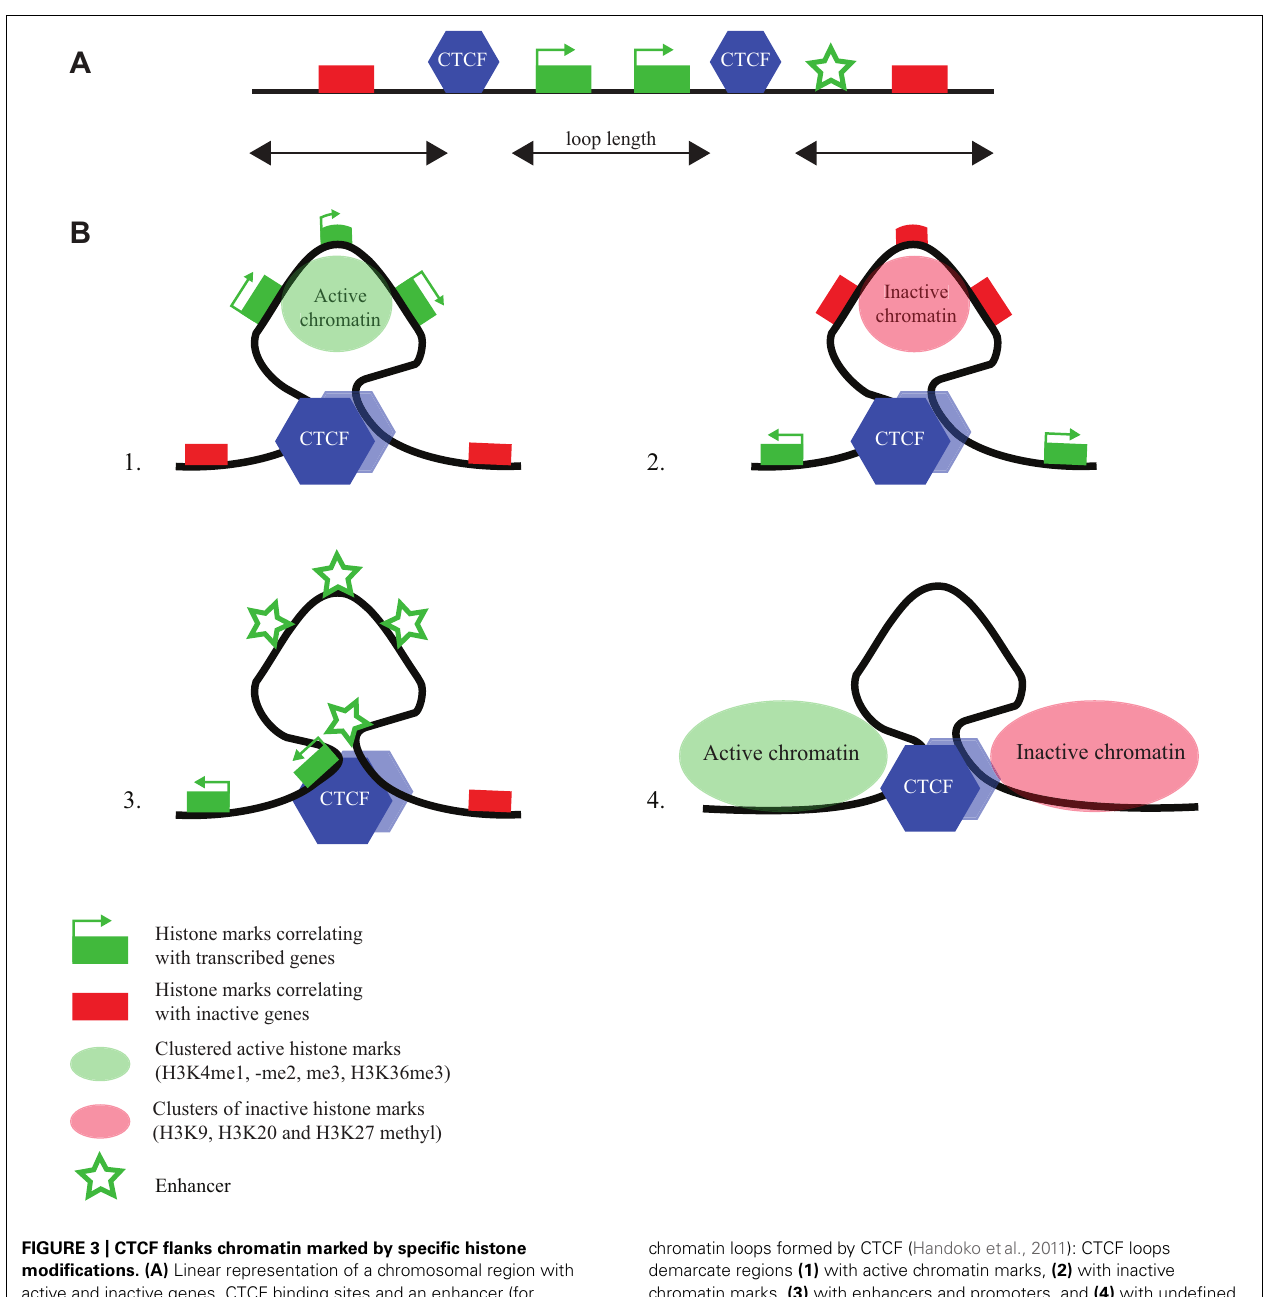
FIGURE 3 | CTCF flanks chromatin marked by specific histone modifications. (A) Linear representation of a chromosomal region with active and inactive genes, CTCF binding sites and an enhancer (for explanation of symbols, see bottom figure). (B) ChIA-PET reveals different